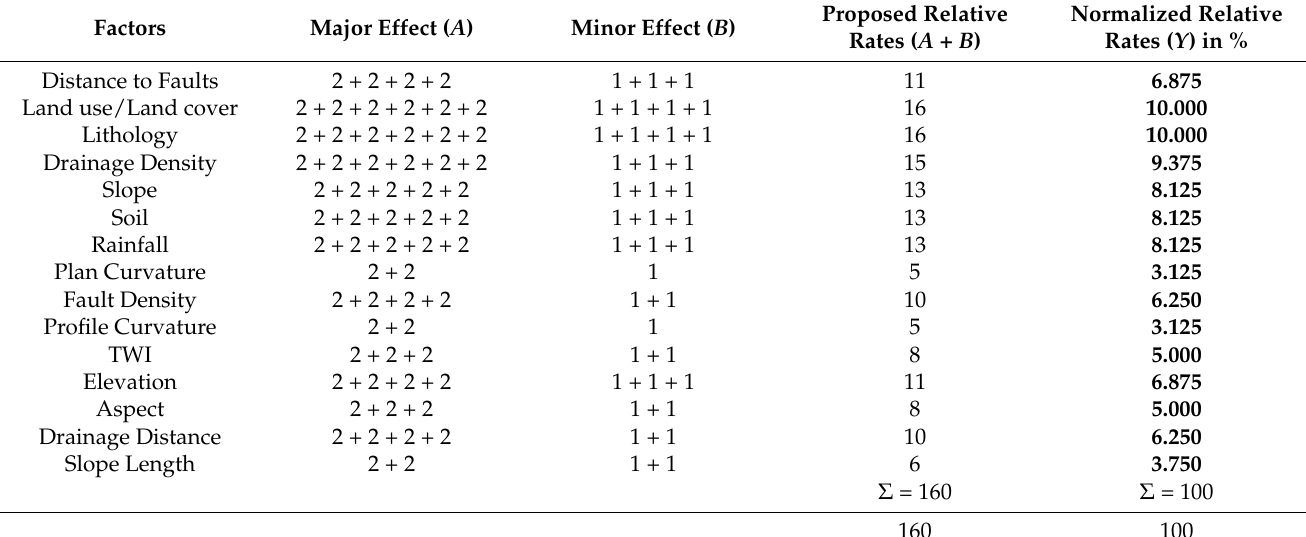
Table 4. Relative rates and scores for each potential